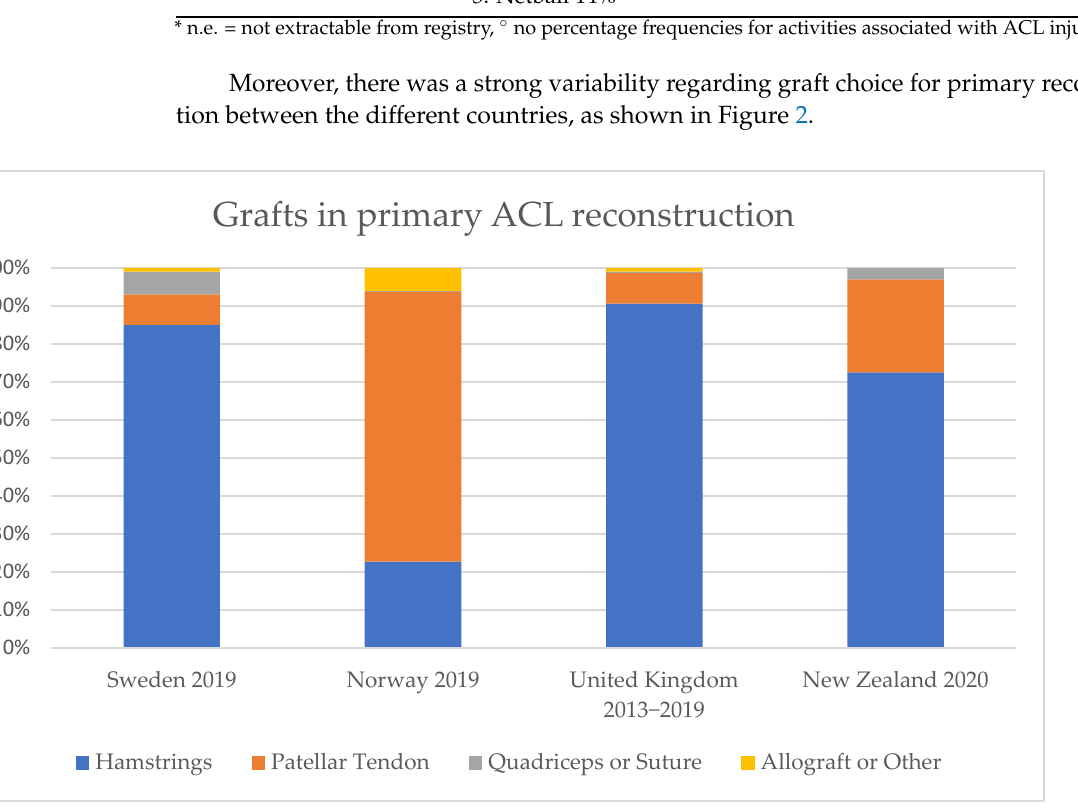
Figure 2. Percentage frequency of different grafts used in primary ACL reconstructions. For example, hamstring tendons (HT) accounted for 90% of grafts in primary ACL reconstructions in the UK, 71% in New Zealand, and 85% in Sweden, but made up only 23% in Norway, respectively, where 71% of grafts in primary ACL reconstructions were patellar tendon grafts (PT). Quadriceps tendons and allografts were rarely used in all four countries, with percentages ranging from 0% to 2% of grafts in primary reconstructions.